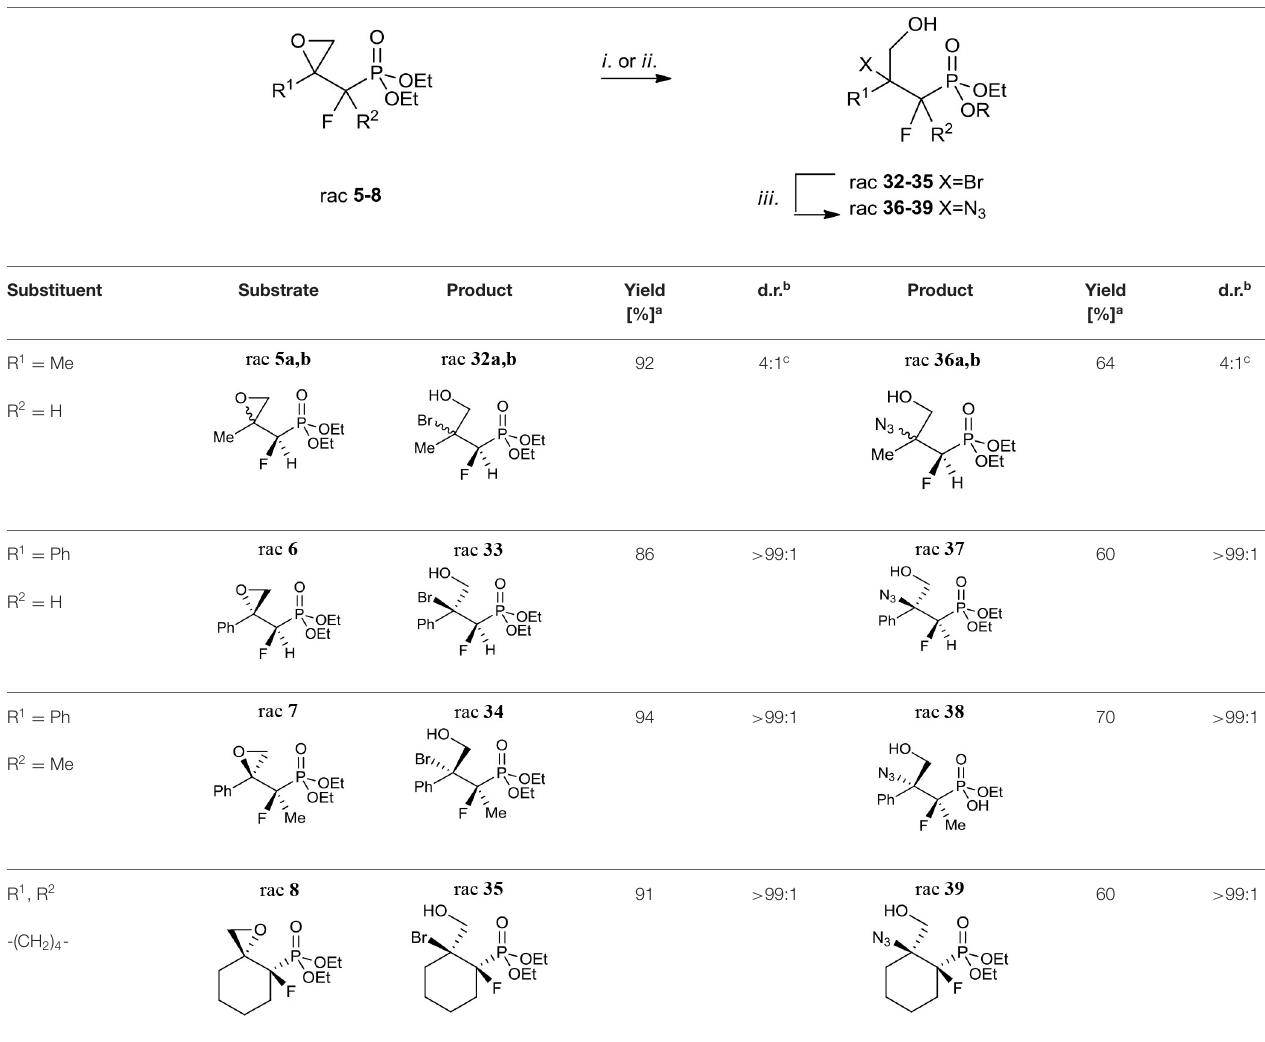
TABLE 6 | Synthesis of fluorinated β -bromo- or β -azido- γ -hydroxy- alkylphosphonates 32–35 or 36–39 .